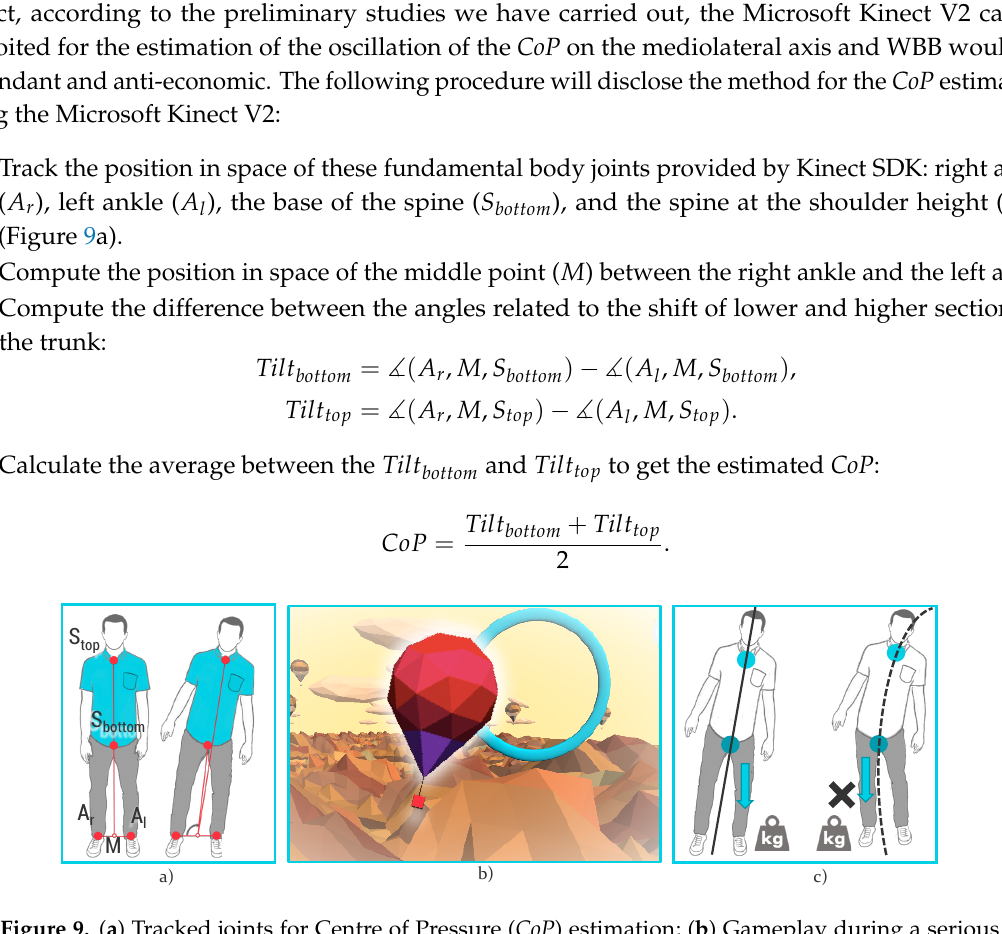
Figure 9. ( a ) Tracked joints for Centre of Pressure ( CoP ) estimation; ( b ) Gameplay during a serious game session; ( c ) Erroneous balance shift